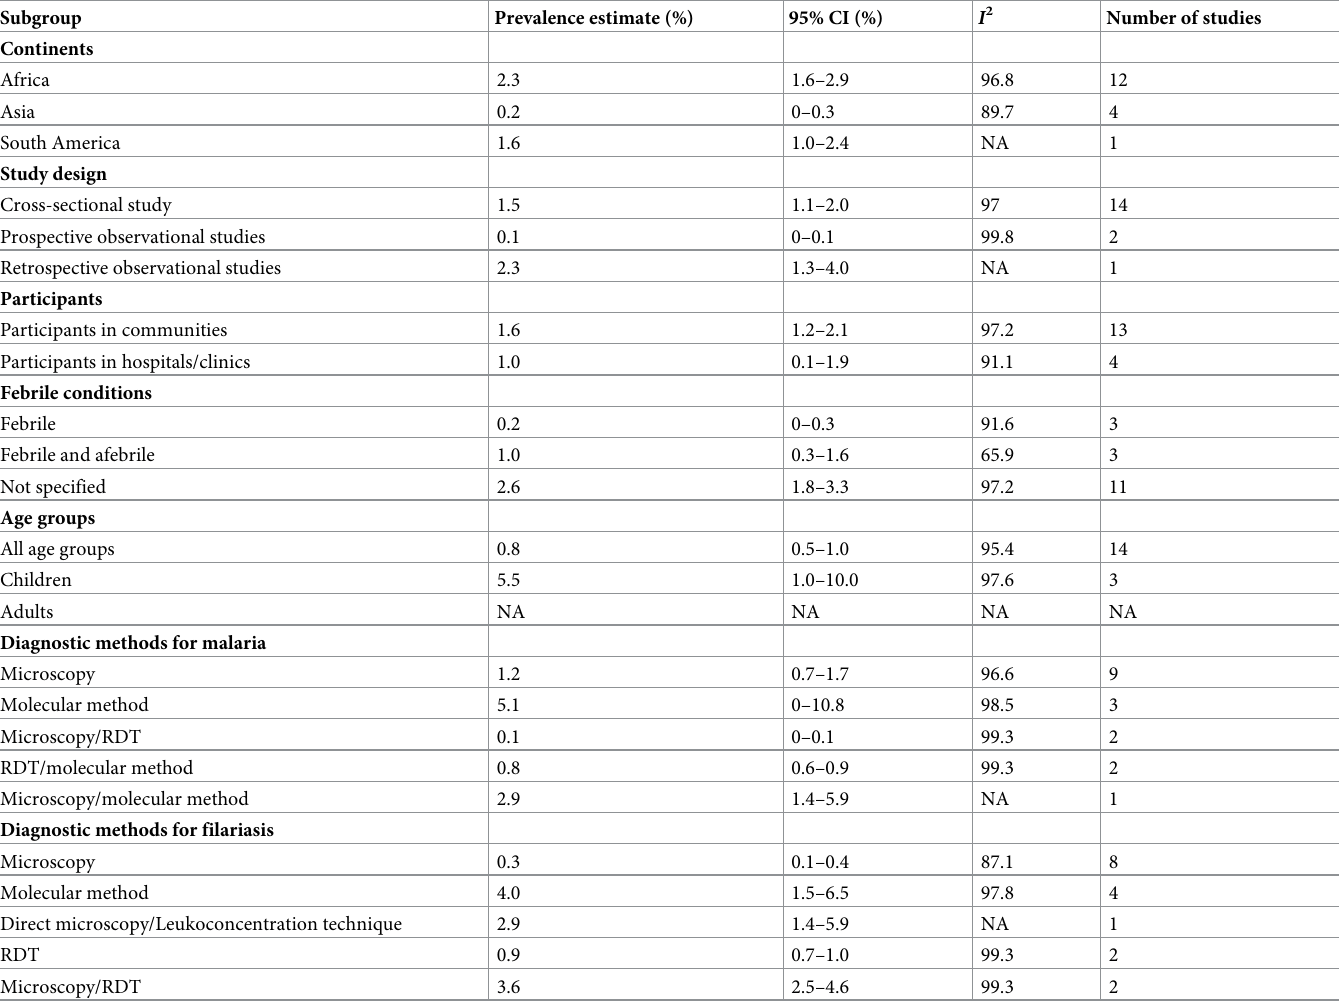
Table 2. Subgroup analyses of the prevalence of malaria and filariasis co-infections among selected